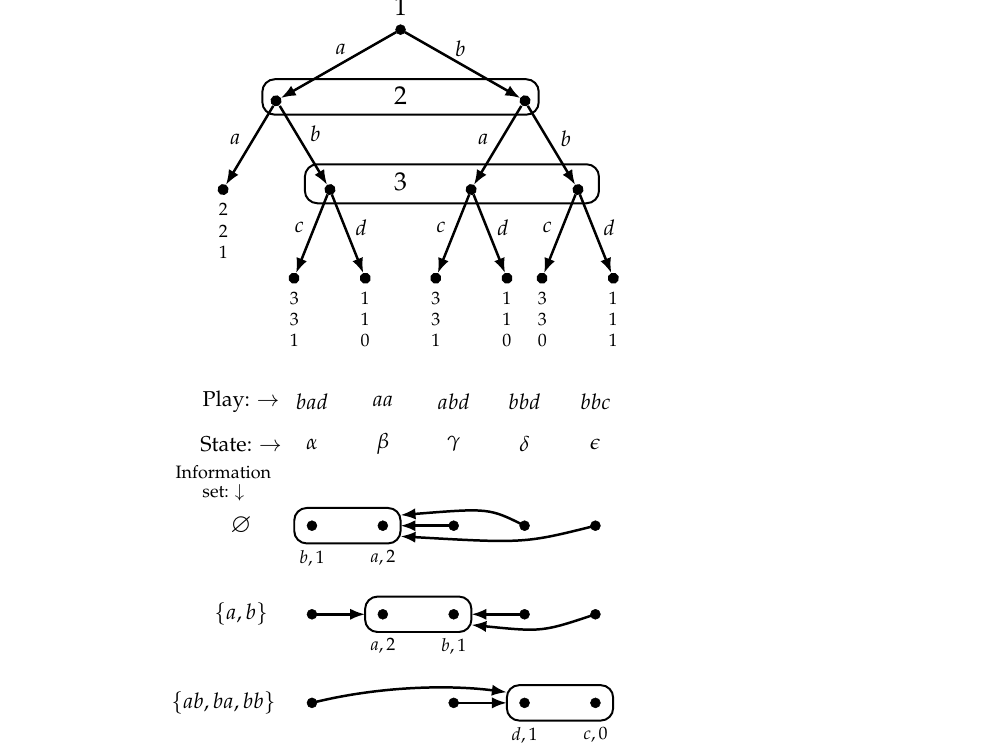
Figure 5. The top part reproduces the game of Figure 1 and the bottom part shows a model of